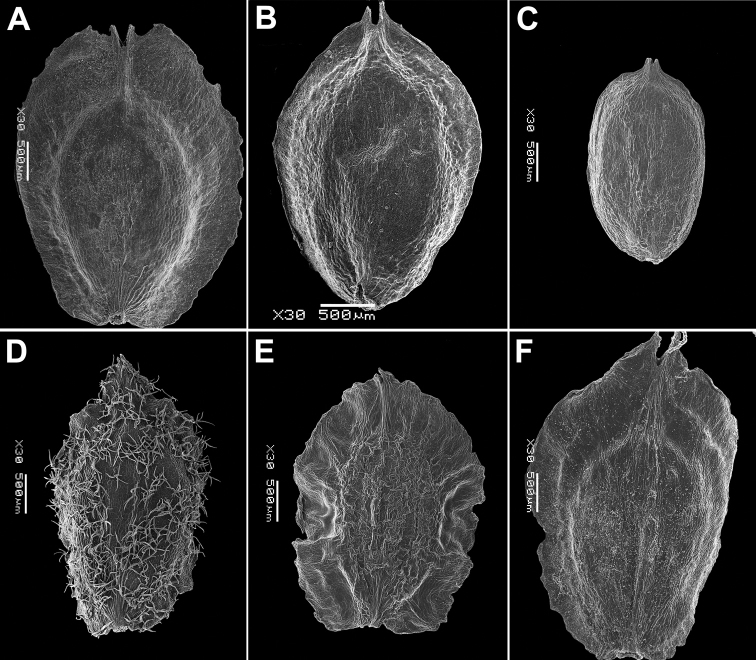
SEM micrographs of Corispermum fruits: AC.falcatumBC.nanumCC.pamiricumDC.dutreuiliivar.montanumEC.dutreuiliivar.dutreuiliiFC.pseudofalcatum. Magnification: 30×.